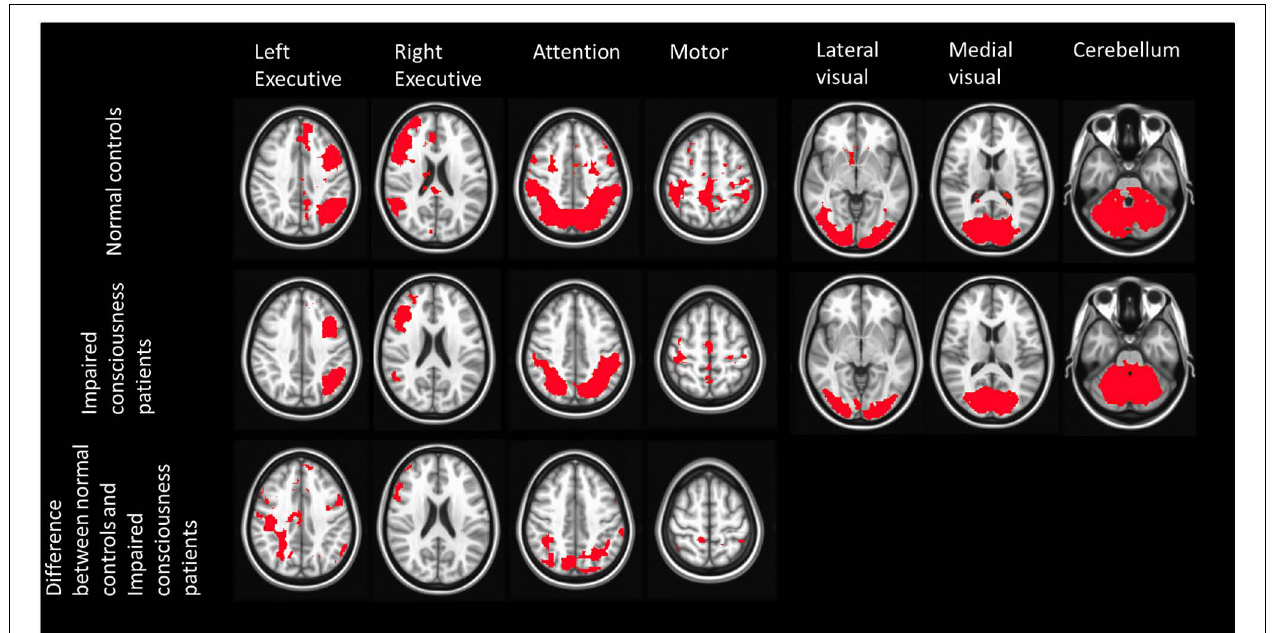
network, right executive network, attention network, motor network ( p < 0.05). No significant difference was found between these two groups in the lateral visual network, medial visual network, and cerebellum.